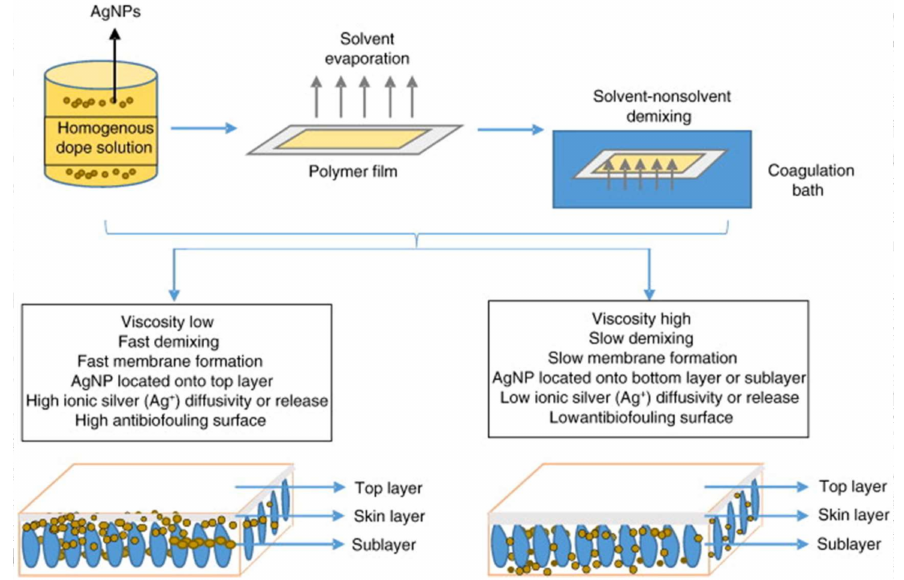
Figure 6. Description of the location of Ag-NP in the nanocomposite membranes developed by Sile-Yuksel et al.